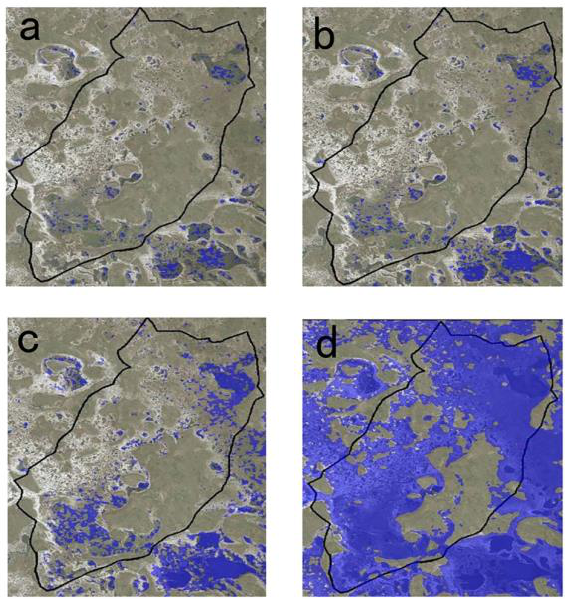
Figure 8. Effect drawing of different level simulated from β values. ( a ) β value is 4%; ( b ) β value is 7%; ( c ) β value is 20%; and ( d ) β value is 70%.